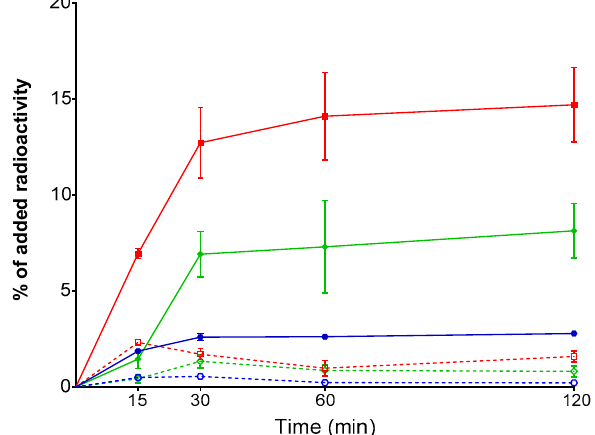
Figure 3. Time-dependent, NTS1R-specific cell uptake curves of [ 99m Tc]Tc–DT1 in AsPC -1 (red lines), PANC-1 (green lines), and MiaCapa-2 (blue lines) cells at 37 °C (solid lines: internalized fraction; dotted lines: membrane-bound fraction). Results represent average values ± SD ( n = 3, in triplicate); non-specific values were obtained in the presence of 1 µ M NT, and were subtracted from totals to provide specific values. The study was conducted with cells as confluent